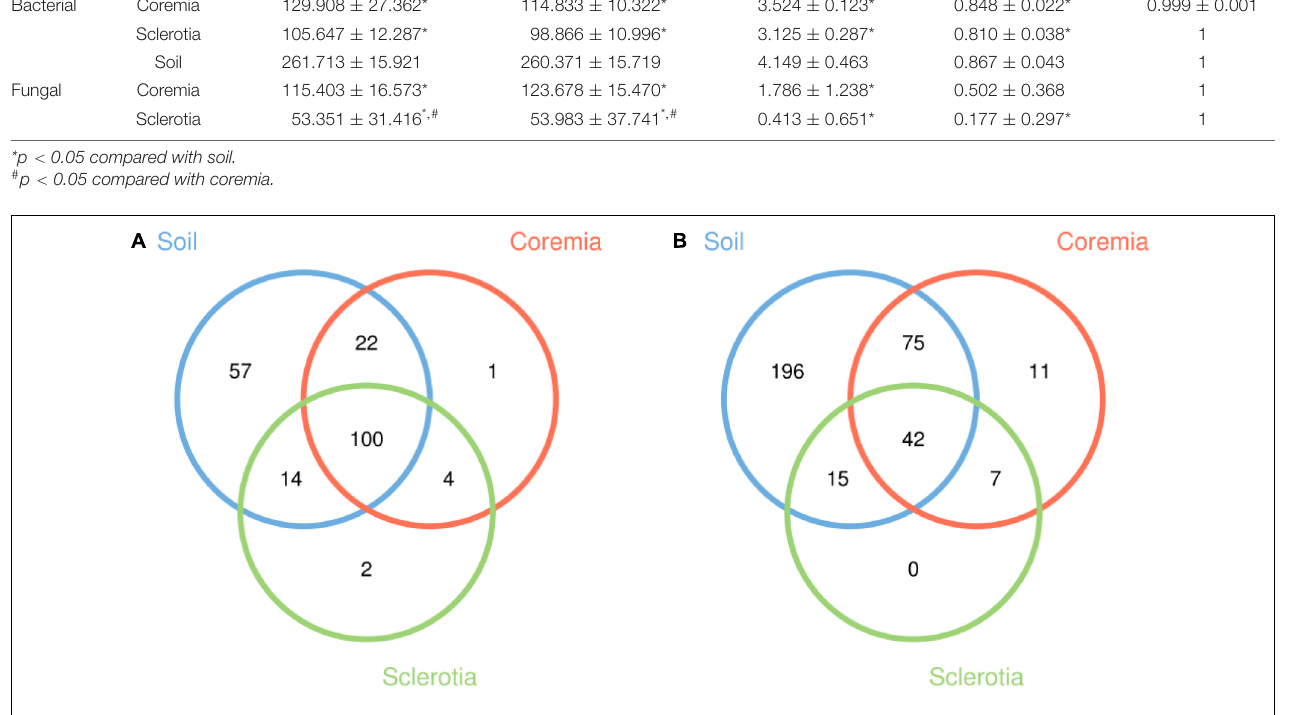
FIGURE 1 | Venn diagrams depicting the unique and shared operational taxonomic units (OTUs) from (A) the bacterial and (B) the fungal community among the soil, coremia, and sclerotia